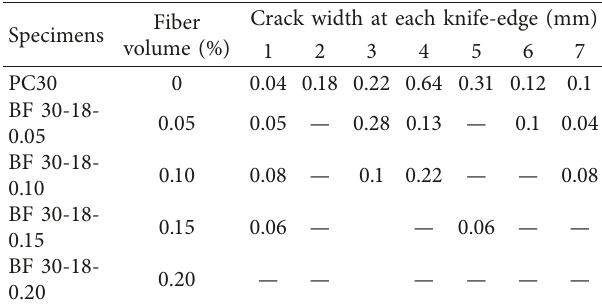
Table 8: Crack width of test specimens with different fiber volume fractions.